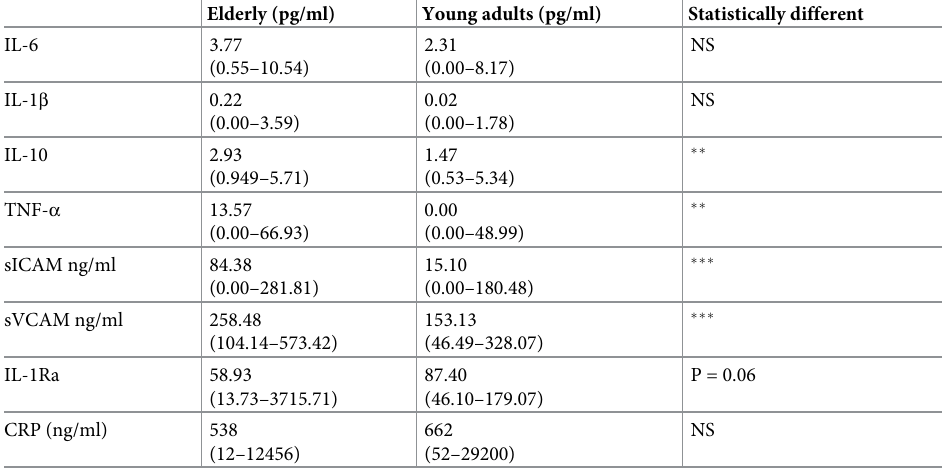
Table 3. Concentration of pro-inflammatory markers in serum in median pg/ml with range (minimum to maxi- mum value) in elderly (n = 30) and young adults (n = 15)